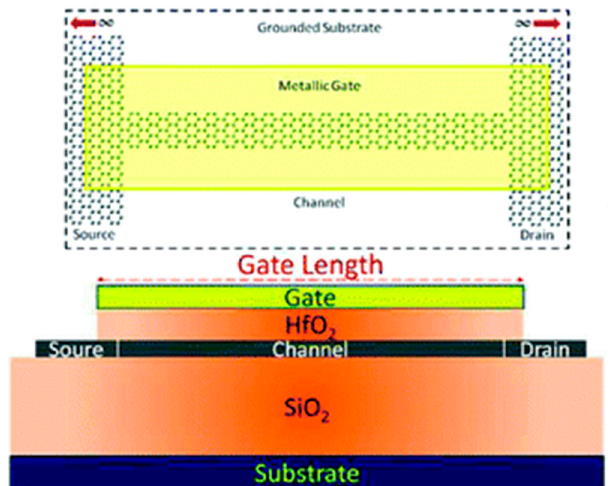
Figure 2. Graphene nanoribbon field-e ff ect transistor (GNR FET). Top view and side view [10]. Copyright.